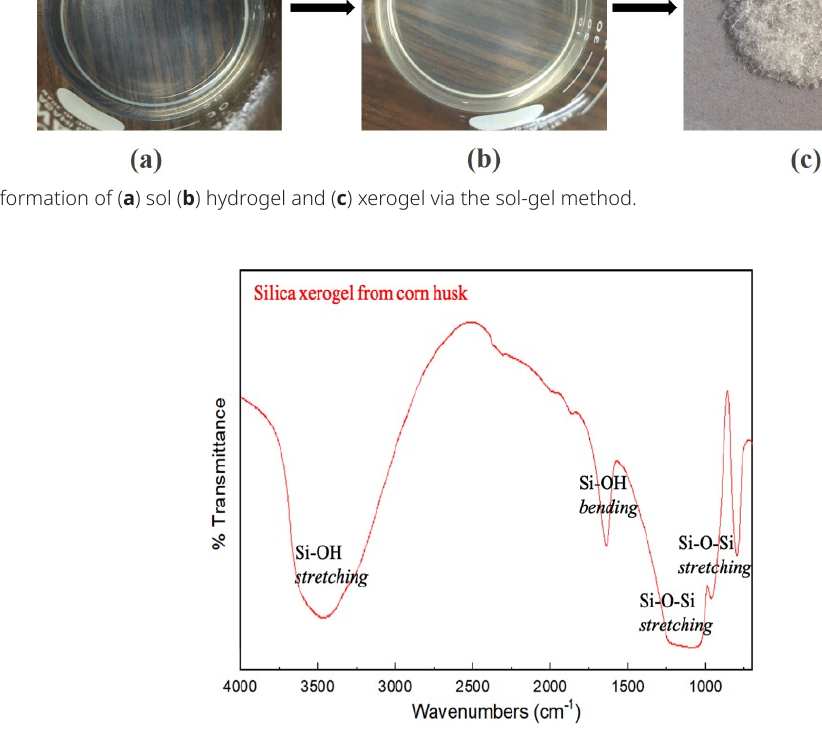
Figure 2. Fourier transform infrared spectroscopy (FTIR) spectrum of silica xerogel prepared from corn